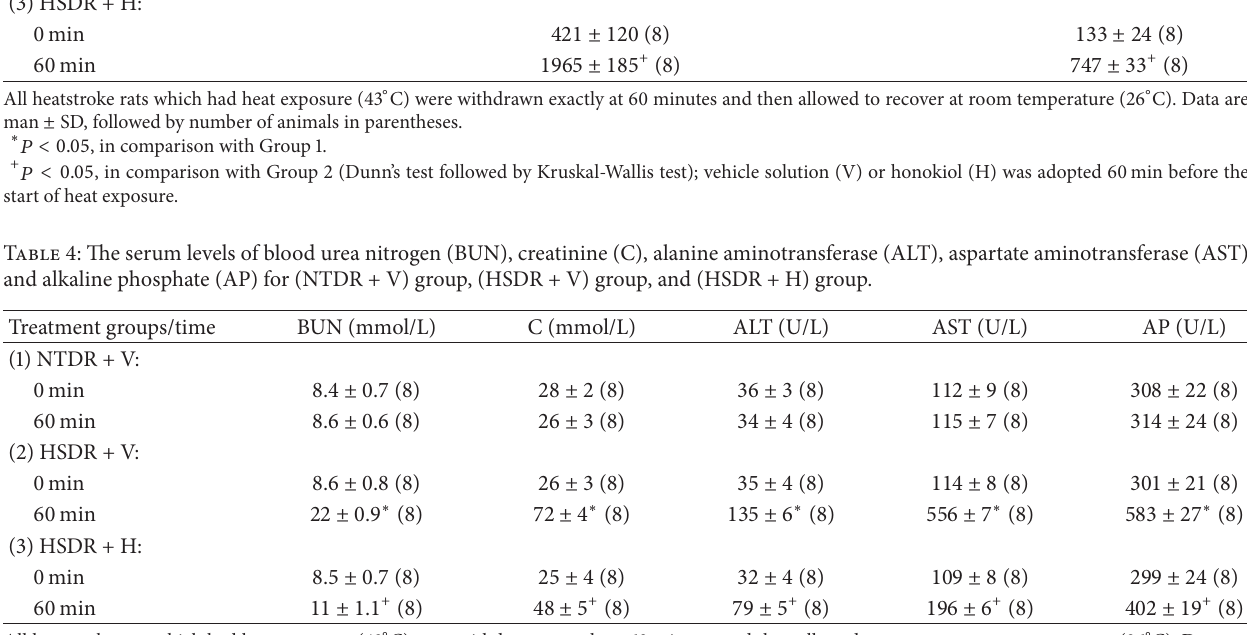
renal dysfunction including creatinine, blood urea nitrogen, alanine aminotransferase, aspartate aminotransferase, alka- line phosphatase, and lactate hydrogenase, (d) attenuated the plasma systemic inflammatory response molecules